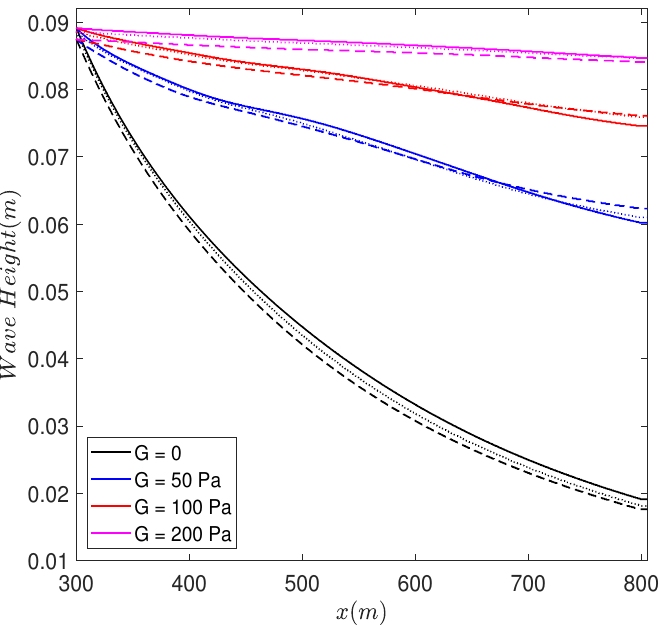
Figure 9. Spatial variation of cnoidal wave H over viscous ( G = 0) and viscoelastic mud with shear moduli of G = 50–200 Pa. dot-line: U = 0, solid-line: U = +0.15 m/s , and dashed-line: U = − 0.15 m/s. The mud patch is located at x = 300–800 m, ζ = 100, h = 1.00 m, d m = 0.12 m, and ρ m = 1111 kg/m 3